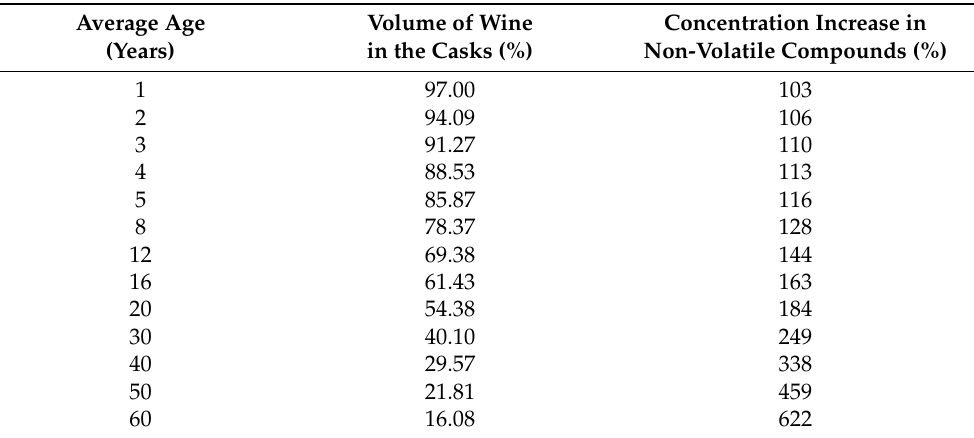
Table 2. Effect of a merma of 3% in volume with ageing for the different average ageing times studied. Data extracted from reference